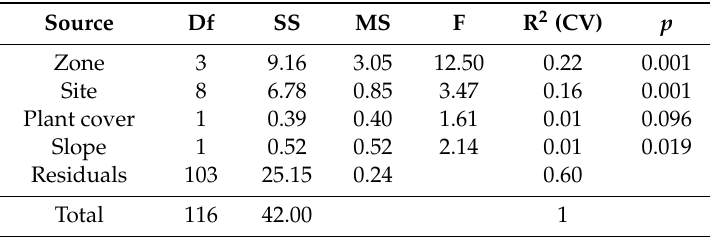
Table 3. Results of PERMANOVA analysis of species composition and environmental variables (zone, site, slope and plant cover) . p < 0.05 are considered significant. Df = degrees of freedom; SS = sum of squares; MS = Mean squares; F = statistical; R 2 = coefficient of variation. Source Df SS MS F Zone